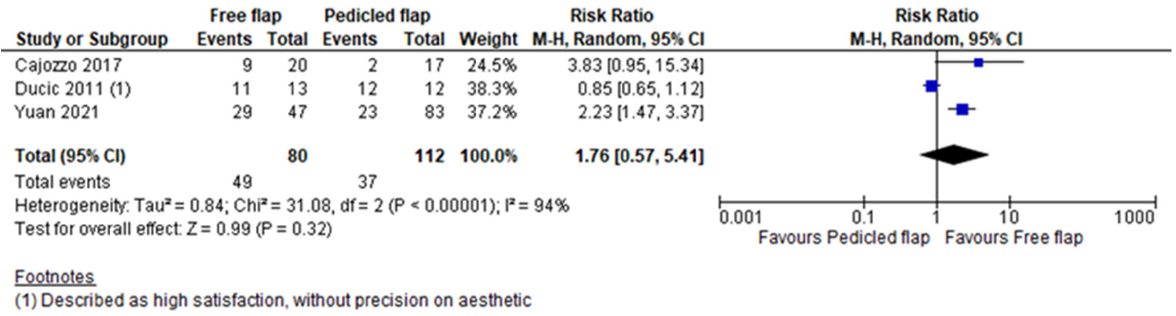
Figure 5. Revision surgery meta-analysis [13,15,16,19,21].